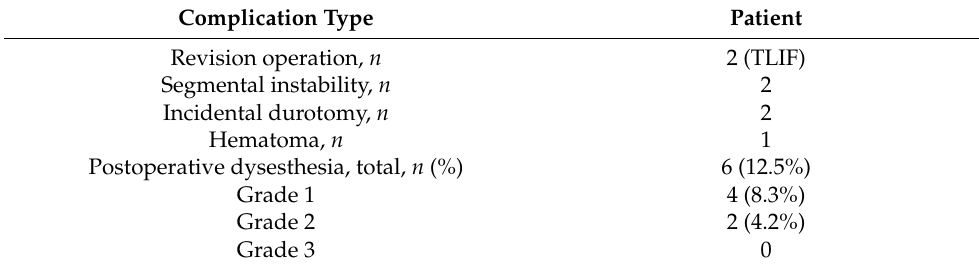
Figure 5. Case example. A 76-year-old female presented with left buttock pain and radiating left leg pain. ( a , b ) Preoperative magnetic resonance imaging (MRI) showing lateral recess stenosis with foraminal to extraforaminal HNP at L5-S1 on the left (arrows). ( c ) Spondylolysis without spondylolisthesis was found on preoperative lateral radiography. ( d , e ) Sufficient decompression of the lateral recess, foraminal to extraforaminal lesions was confirmed on postoperative MRI (arrowheads). ( f ) There was no spondylolisthesis progression on lateral radiography six months after the operation. Postoperative dysesthesia did not occur. Table 2. Postoperative